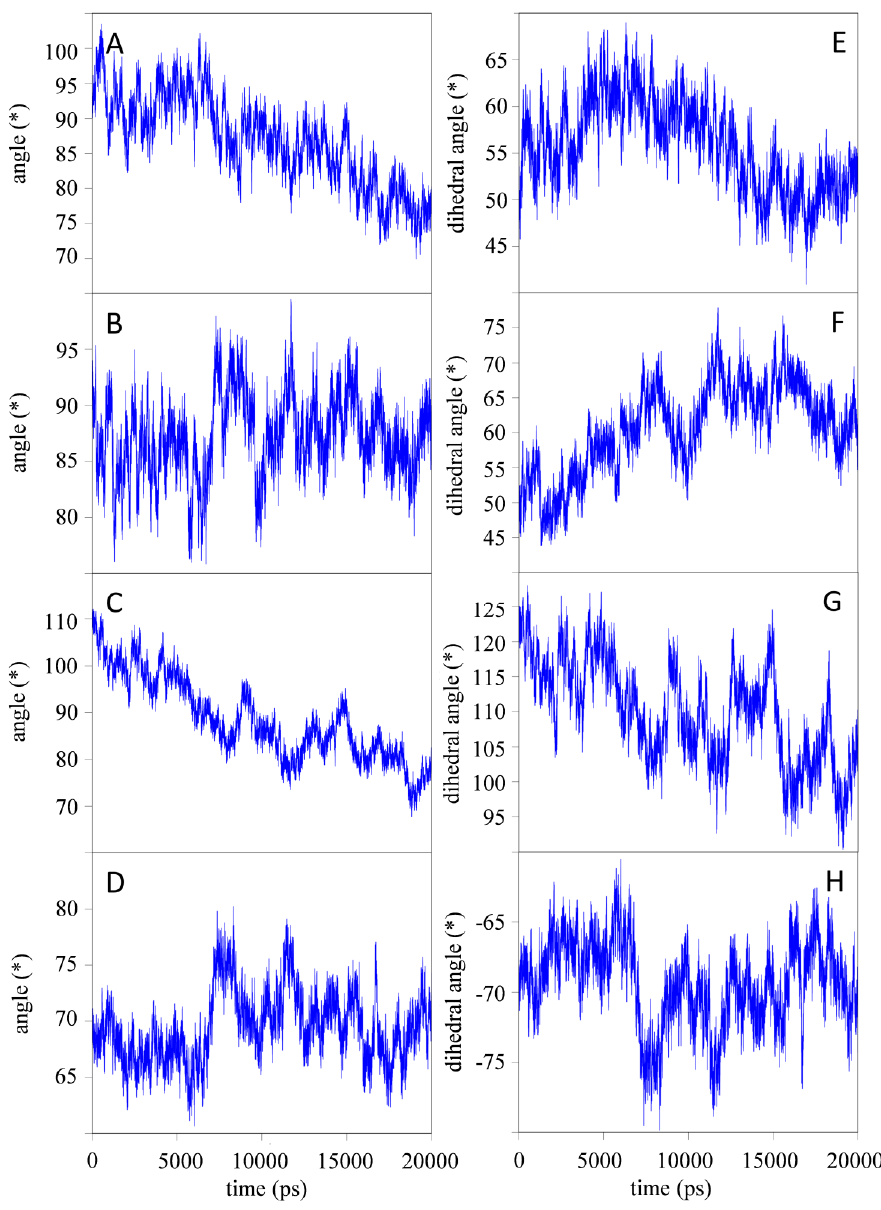
Figure 3. Relative orientation of individual domains as defined through the (dihedral) angles (in degree) as a function of time for simulation H7. ( A ) angle